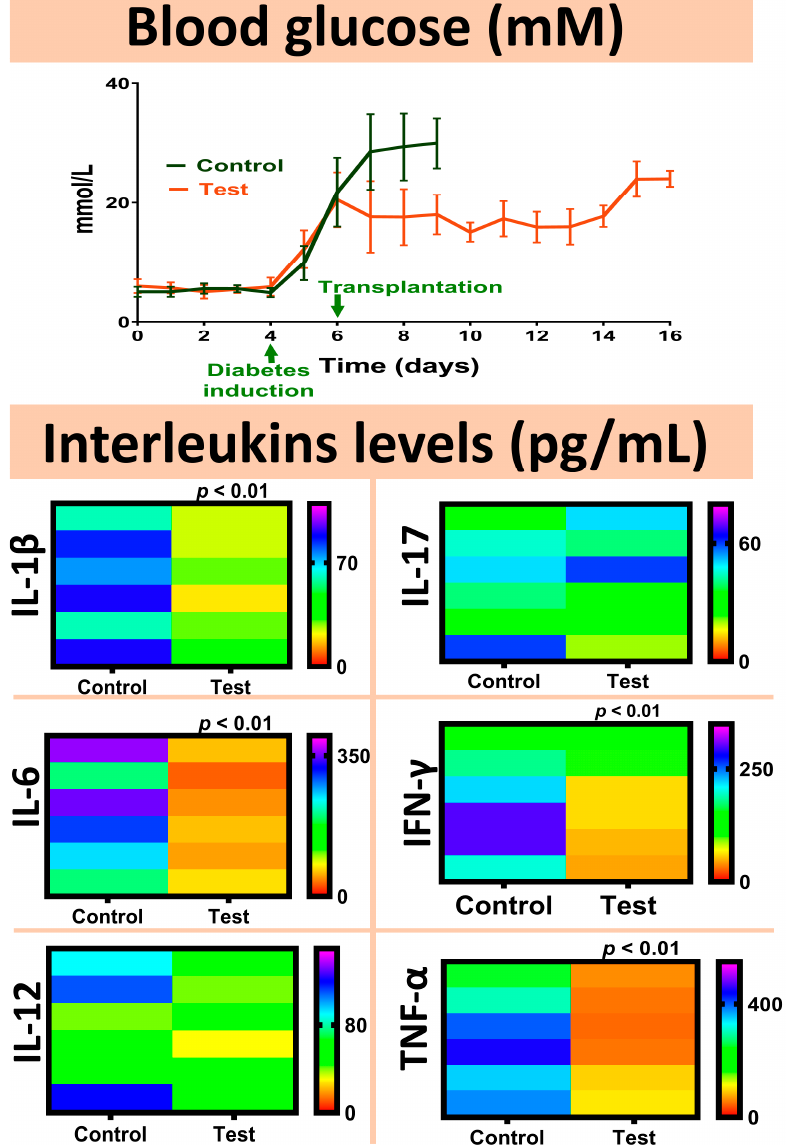
Figure 4. Daily blood glucose concentrations as well as plasma concentrations of IL-1 β , IL-6, IL-12, IL-17, IFN- γ and TNF- α . Data are mean ± SEM. (n = 7).